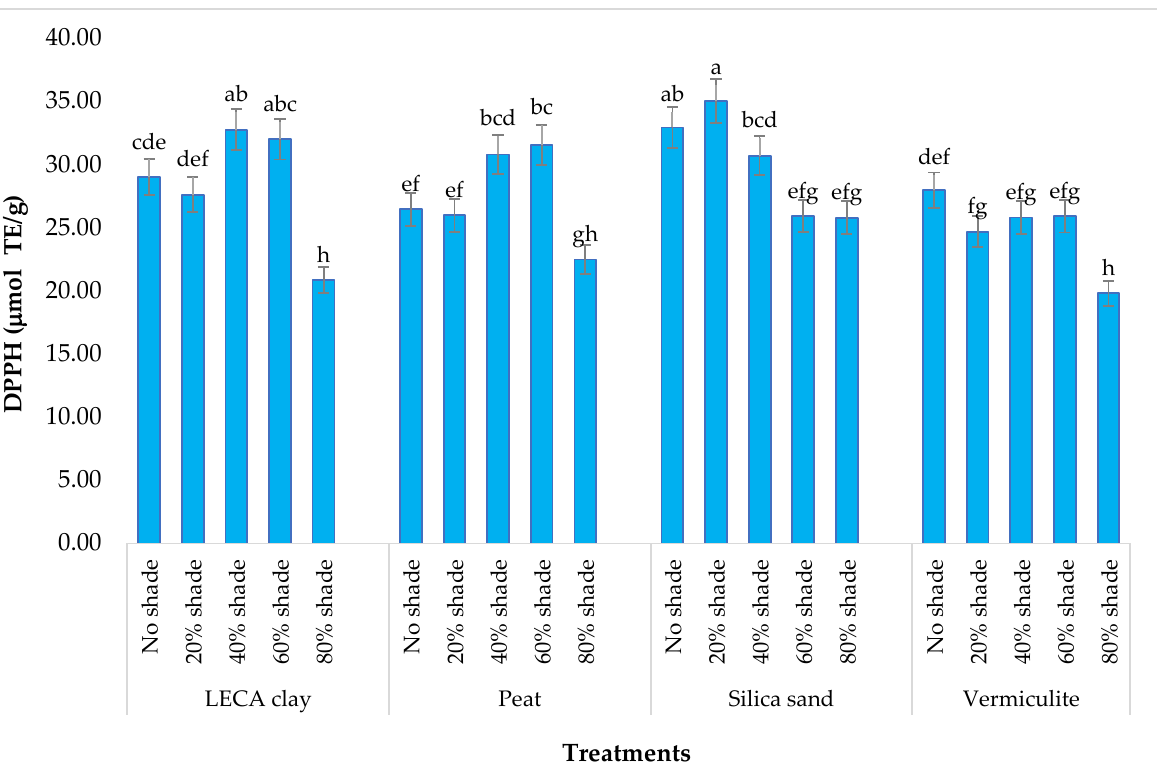
Figure 8. The effect of different growth media and different shade levels on total DPPH content in the flower buds of T. divaricata. Means followed by the same letter did not differ by Tukey ’ s test ( p > 0.05).